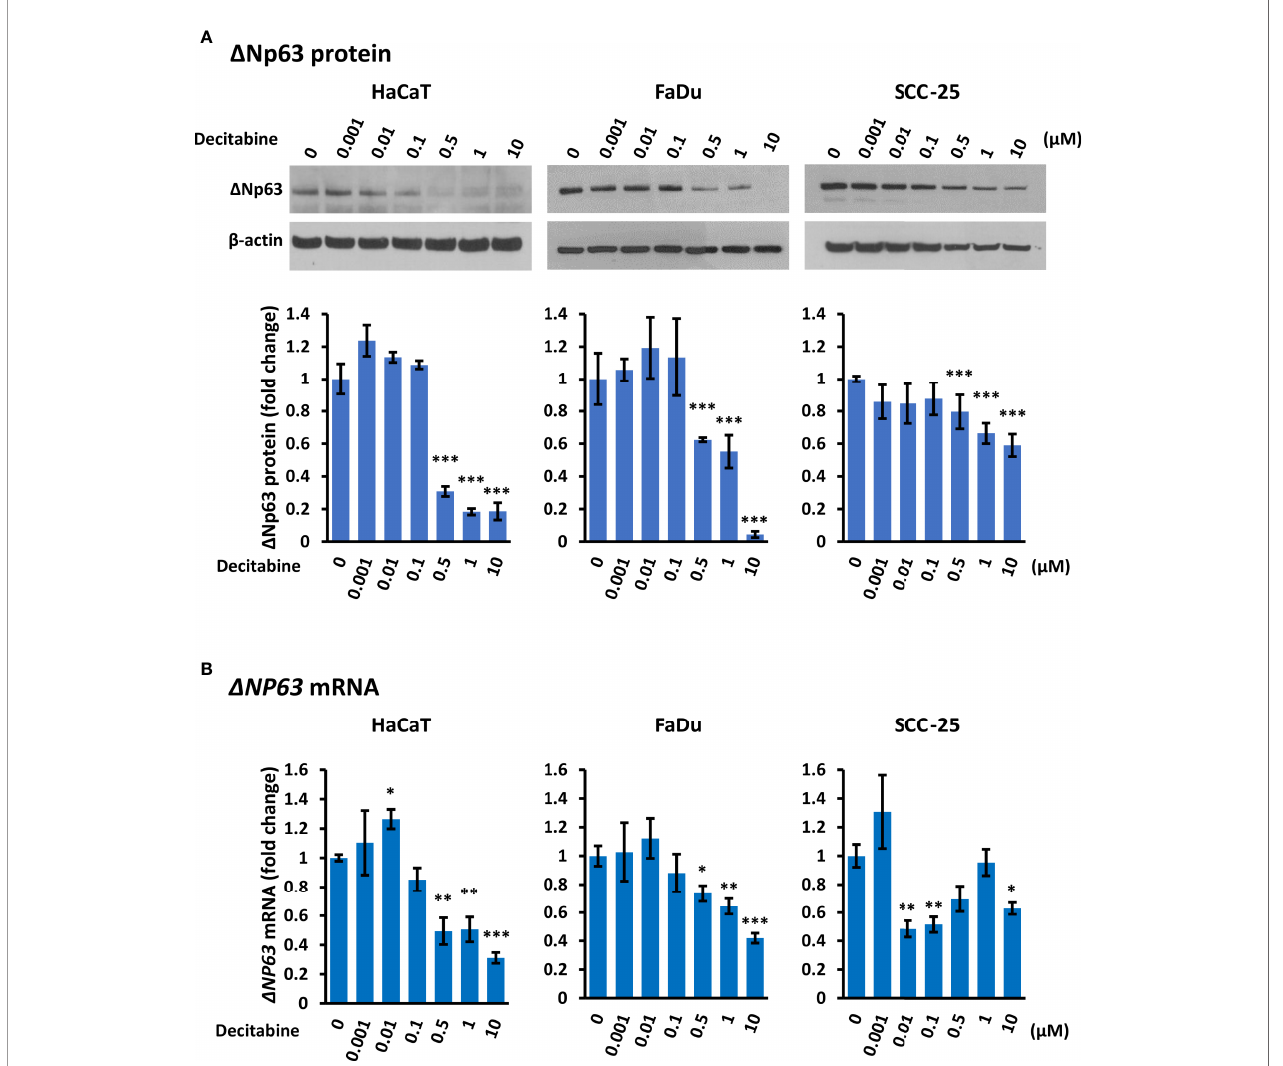
FIGURE 2 | Decitabine reduces D Np63 and mRNA levels in squamous cells. (A) Representative Western blots and densitometric quantitation of D Np63 in HaCaT, FaDu and SCC-25 cells treated with the indicated concentrations of decitabine for four days. b -actin is shown as loading control. Densitometry data represent fold change ± SEM compared to untreated cells (0, DMSO only; n = 3 for each dose in each cell line) and normalized to b -actin. (B) D NP63 mRNA levels normalized to ACTB mRNA (n = 3 to 5 biological replicates, each with technical triplicates). Data are shown as fold change ± SEM compared to untreated cells (0, DMSO only). *p < 0.05; **p < 0.01; ***p < 0.001 compared to